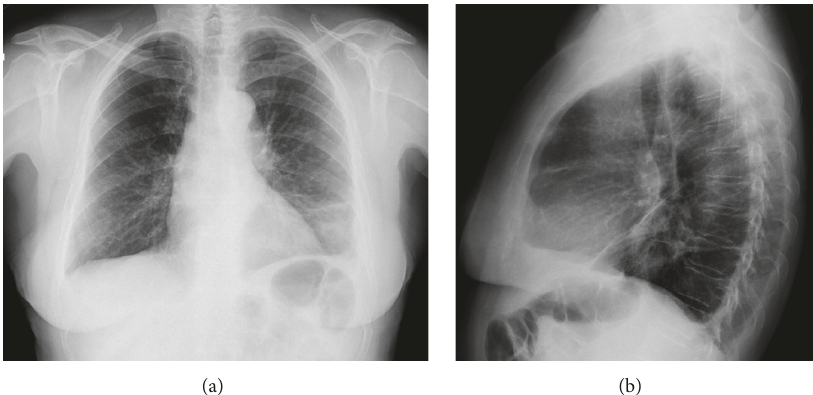
Figure 6: Posteroanterior (a) and lateral (b) chest X-rays. The chest radiography showed a peripheral lesion in the left lower lung and a small volume of pleural effusion on the same side.